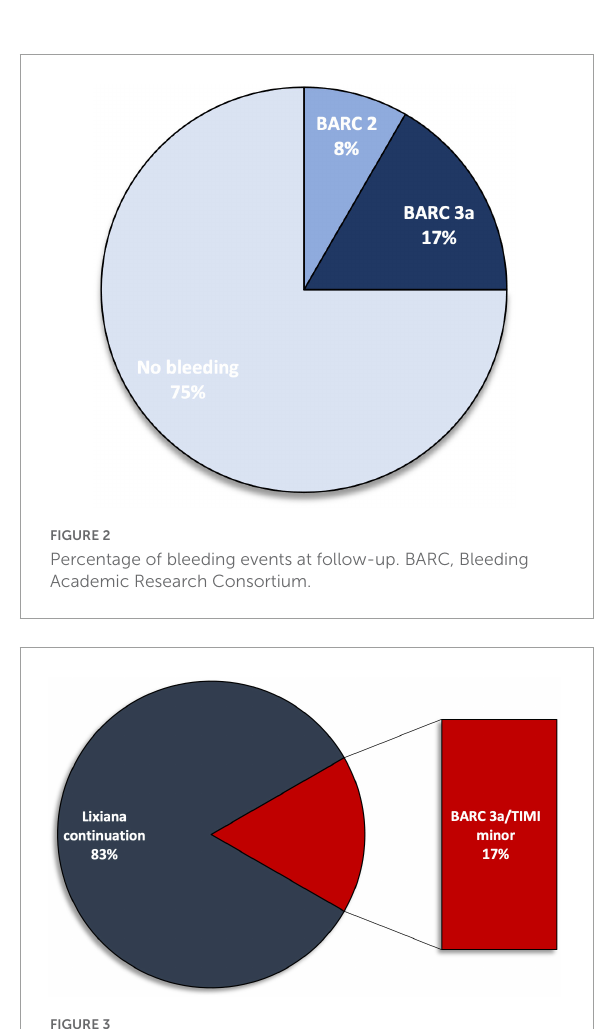
FIGURE3 Edoxaban withdraw rate due to bleeding events during follow up. BARC, Bleeding Academic Research Consortium; TIMI, Thrombolysis in Myocardial